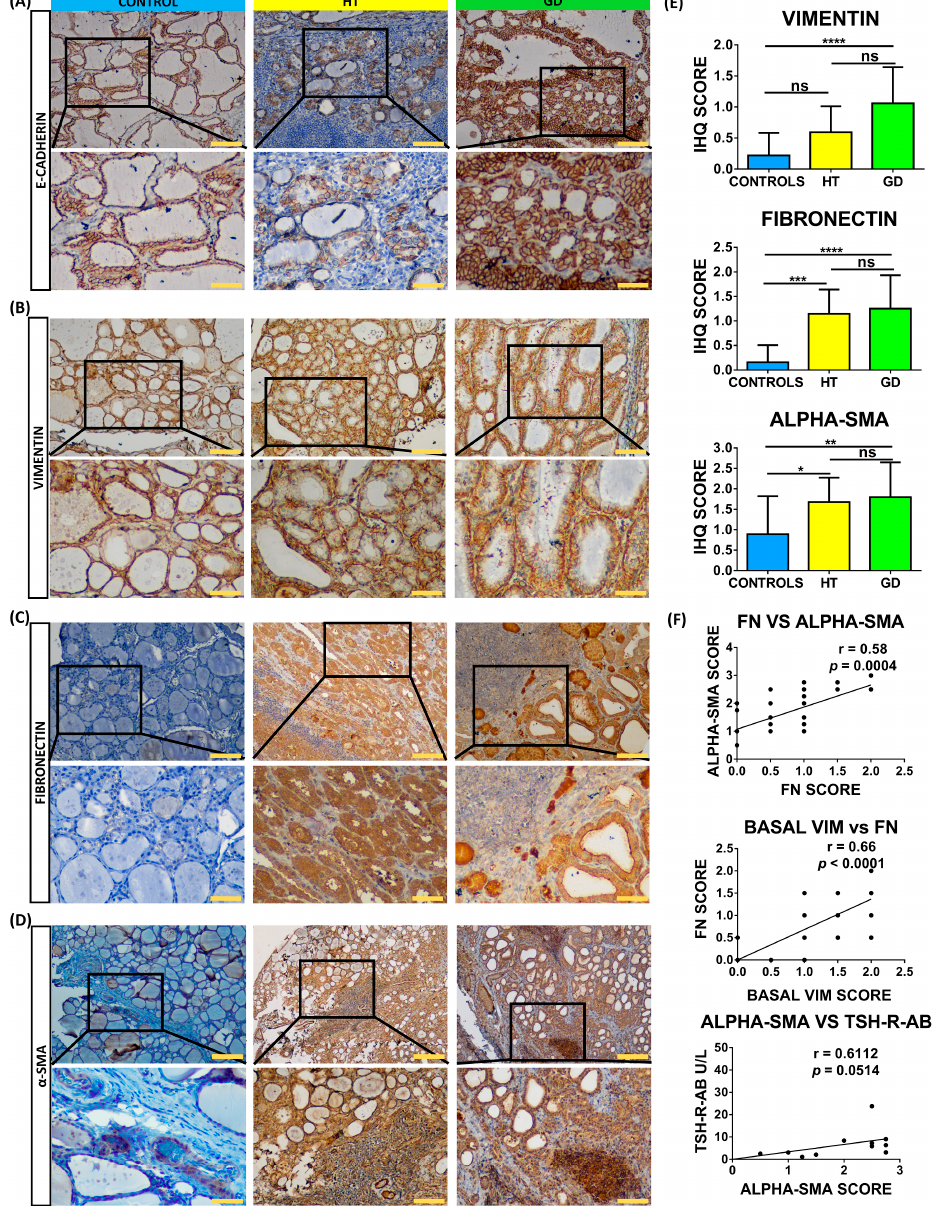
Figure 2. Immunostaining analysis of EMT markers in thyroid tissue from controls, HT, and GD patients. ( A – D ) Immunohistochemistry analysis of E-cadherin, vimentin (VIM), fibronectin (FN), and α -SMA. Scale bar A, B, and C: 200 μ m, zoom 100 μ m. Scale Bar D: 500 μ m, zoom 100 μ m. ( E ) Immunohistochemistry (IHC) score quantitation of basal vimentin, fibronectin, and α -SMA. ( F ) Correlation of marker IHC score with clinical laboratory parameters. Data correspond to the arithmetic mean ± SD. Abbreviations—ns: not significant. * p < 0.05; ** p < 0.01; *** p < 0.005; **** p < 0.0001. Although an increase in fibronectin and α -SMA was found by immunohistochemis- try, this increase was not corroborated by western blot (WB). However, we detected an increase in total vimentin (mean expression 1.51 in HT, 1.10 in GD, and 1.21 in AITD vs. 0.50 in control tissues; p = 0.0091, p = 0.0279 and p = 0.0026, respectively) and cleaved vi- mentin (mean expression 0.90 in GD and 0.68 in AITD vs. 0.24 in controls; p = 0.0135, p = 0.0047, respectively). We also evaluated the expression of ADP-ribosylation factors, such as GTPase 13B (Arl13b), which localize to the cilia. We observed a significantly decreased